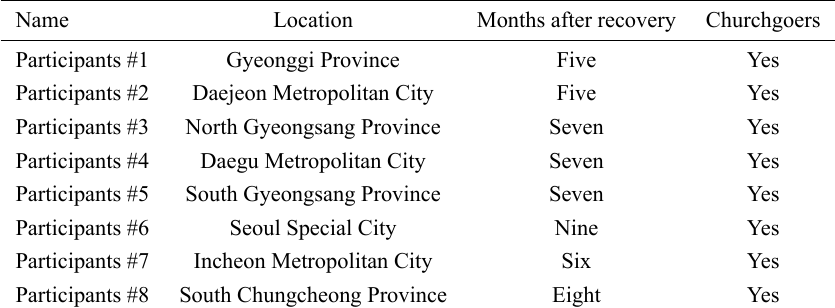
Table 2. Background of the